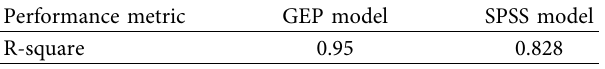
Table 9: Comparison of model performance